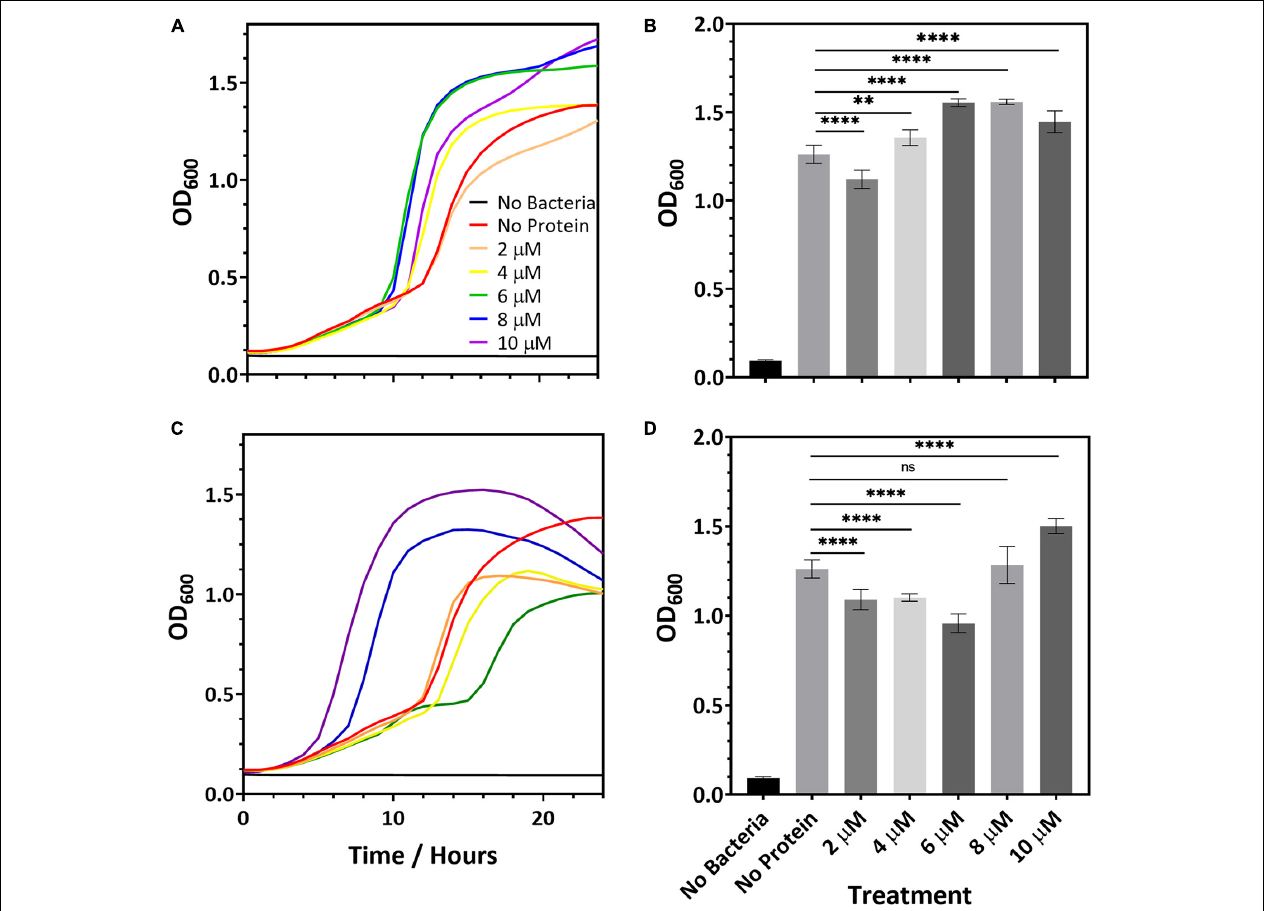
FIGURE 2 | Representative microbial growth curves in the presence of R2ab (A) and amidase (C) . Growth curves are shown for S. epidermidis when the media was mixed with (A,B) R2ab or (C,D) amidase. Concentrations added for each protein domain are 0 µ M (red), 2 µ M (orange), 4 µ M (yellow), 6 µ M (green), 8 µ M (blue), and 10 µ M (purple). The black curve shows a control with no bacteria added. Panels (B,D) show the average and standard deviation of OD 600 at 18 h for R2ab and amidase, respectively, for the different treatments ( N = 8). A one-way ANOVA test [ (B) : F (5, 42) = 120.4, p < 0.0001 and (D) : F (5, 41) = 77.51, p < 0.0001] with Tukey’s post hoc analysis was performed to determine the levels of significance between groups (n.s. is not significant; ** p < 0.005 and **** p < 0.0001).